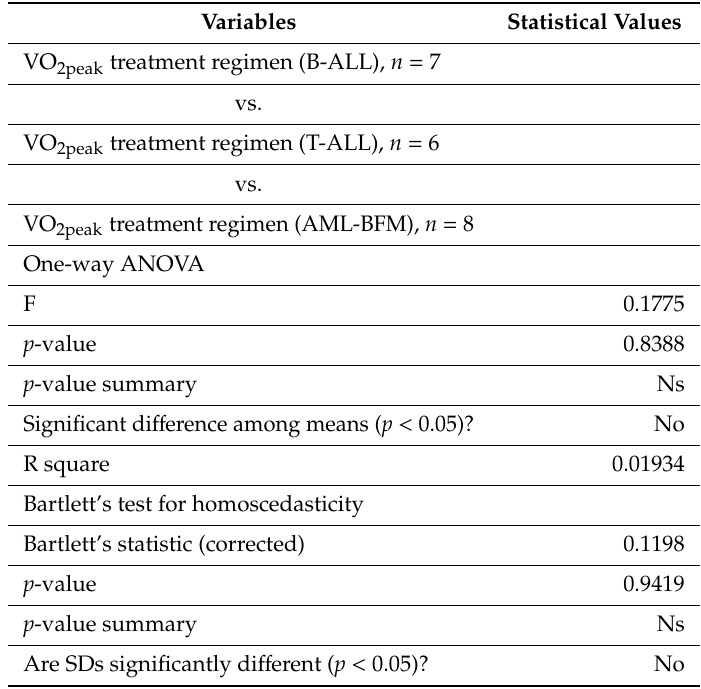
Table 5. Relationship between the level of exercise capacity (VO 2peak ) and the treatment regimen (B-ALL, T-ALL, and AML-BFM).